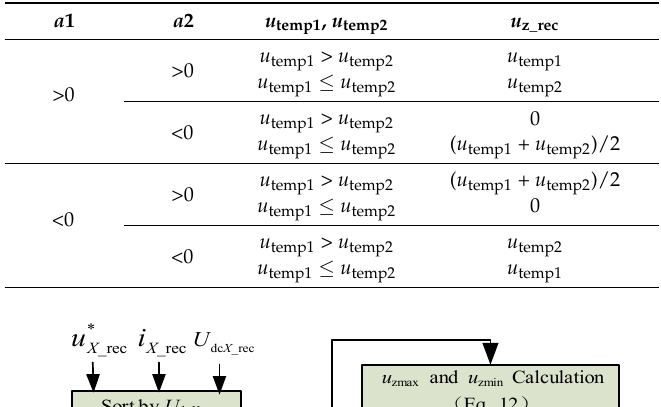
Figure 6. Voltage balancing algorithm of C X _rec . Figure 6. Current paths of S1S2 when i